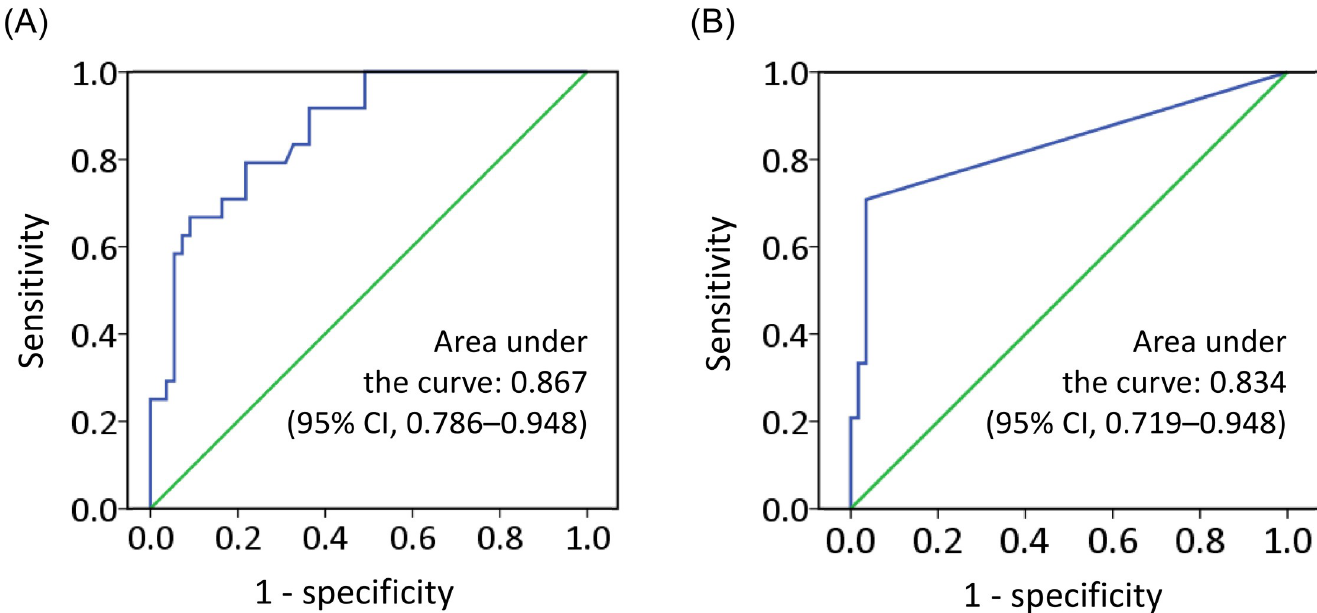
Fig 2. ROC curve analysis of (A) blood MLR and (B) Ct value of qPCR targeting MTB-specific IS6110 in plasma cell-free DNA (MTB-cfDNA) to identify patients with PTB.